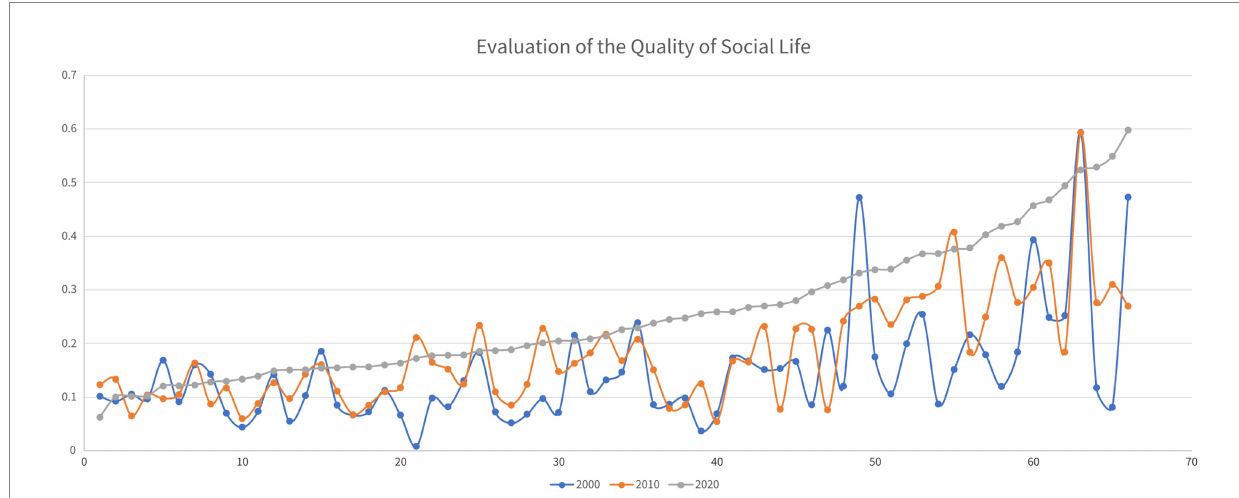
FIGURE 7 Analysis of the evolution of social QoL of Guizhou’s districts and counties from 2000 to 2020.